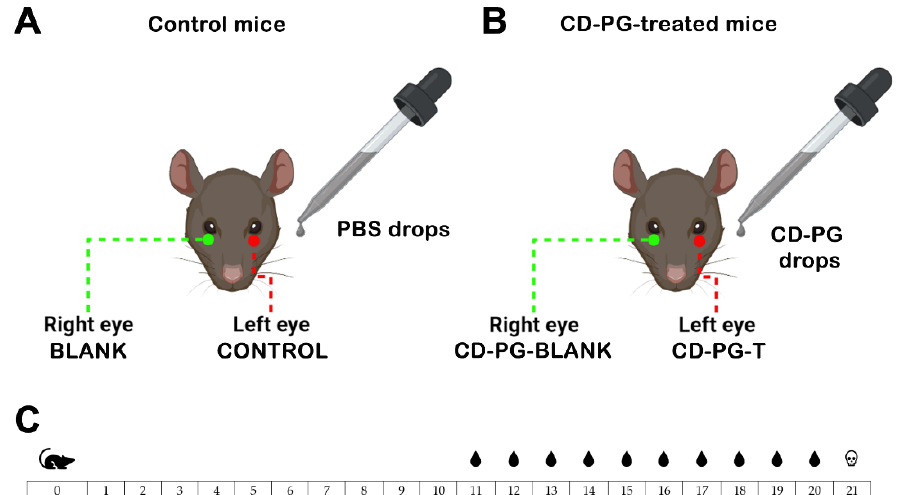
Figure 1. Scheme of the experimental design. ( A ) Control mice: the left eye received a drop of PBS (control) every 12 h, whereas the right eye was left untreated (blank). ( B ) CD-PG-treated mice received a drop of a 1 mg/mL CD-PG to the left eye (PG-T), whereas the right eye (PG-blank) was left untreated to evaluate the possible effects caused by CD-PG administered to the contralateral eye. ( C ) Scheme of the treatment protocol from the time mice were born (day 0) to the time mice were sacrificed (day 21), showing the days the mice received treatment (days